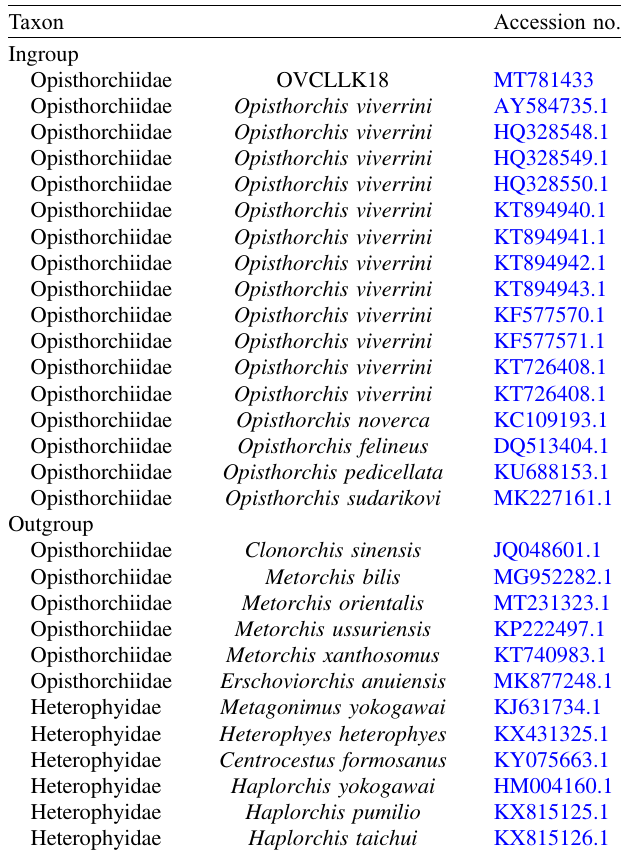
Table 1. GenBank accession numbers of ITS2 sequence data used for phylogenetic